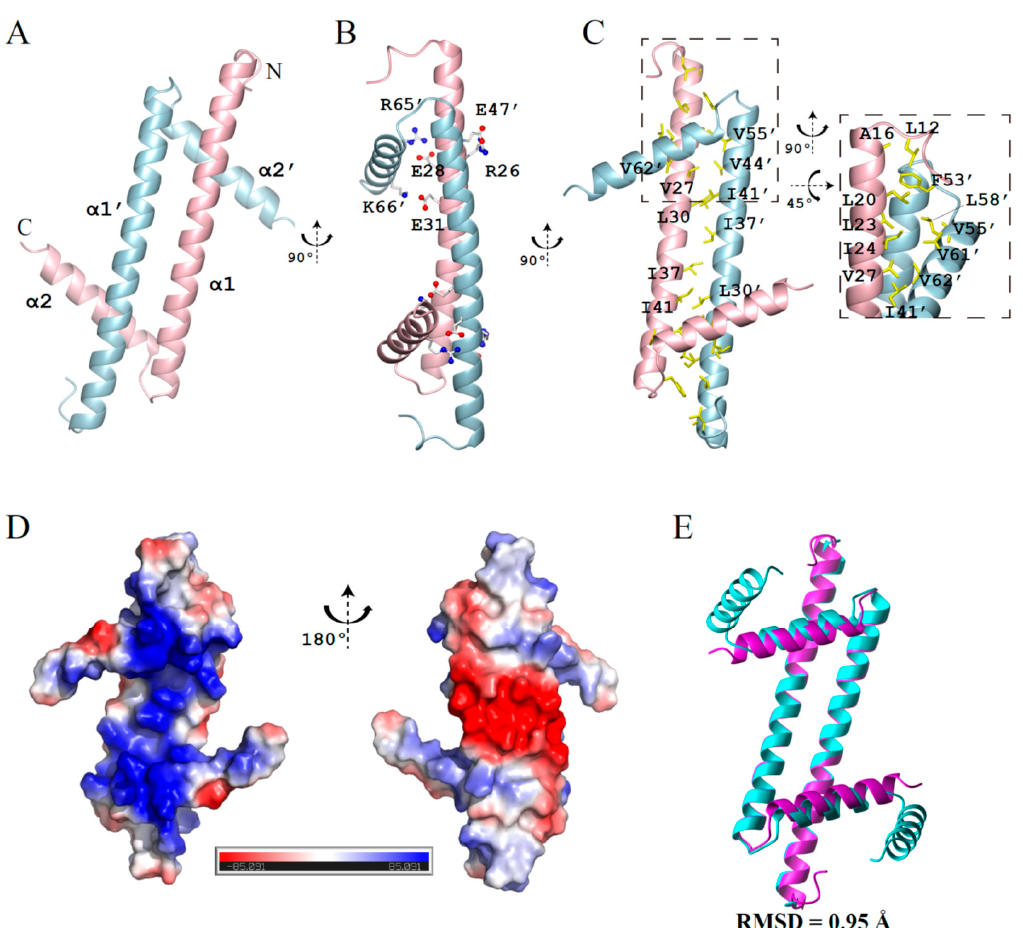
Figure 1. Crystal structure of GapR Δ C17 . ( A ) Ribbon representation of GapR Δ C17 . ( B ) Residues forming intermolecular salt bridges. ( C ) Hydrophobic residues at the dimerization interface. ( D ) The electrostatic potential surface of GapR Δ C17 computed by using APBS [9]. ( E ) Superposition of the GapR Δ C17 dimer with a dimer unit from the full-length tetrameric GapR (PDB code 6CG8).